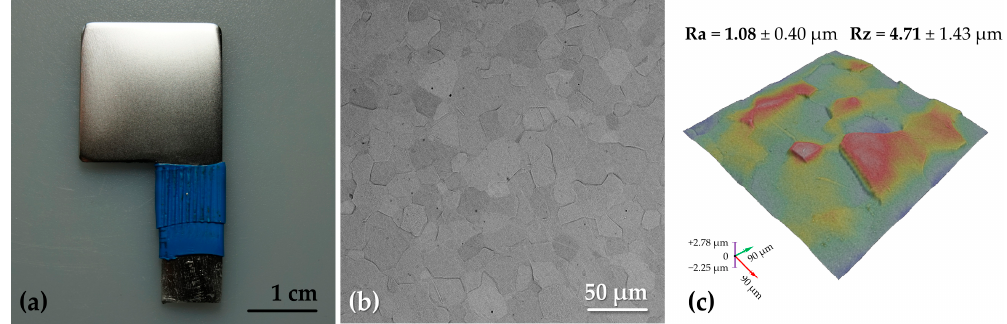
Figure 1. Zirconium specimen prior to plasma electrolytic oxidation (PEO) treatment viewed in macro ( a ) and micro ( b , c ) scales. The micrograph ( b ) and the three-dimensional (3-D) roughness mapping ( c ) were acquired using SEM.